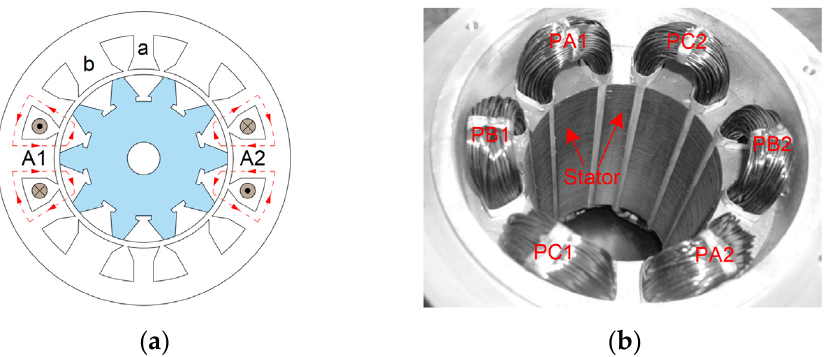
Figure 6. Proposed 12/10 segmental rotor SRM with CW. ( a ) is the radial model for motor where “a” is a narrow tooth and “b” is a wide tooth; ( b ) is the prototyped of motor’s windings and stator. The switching frequency f D of the SRM’s drive circuit can be expressed by (1),